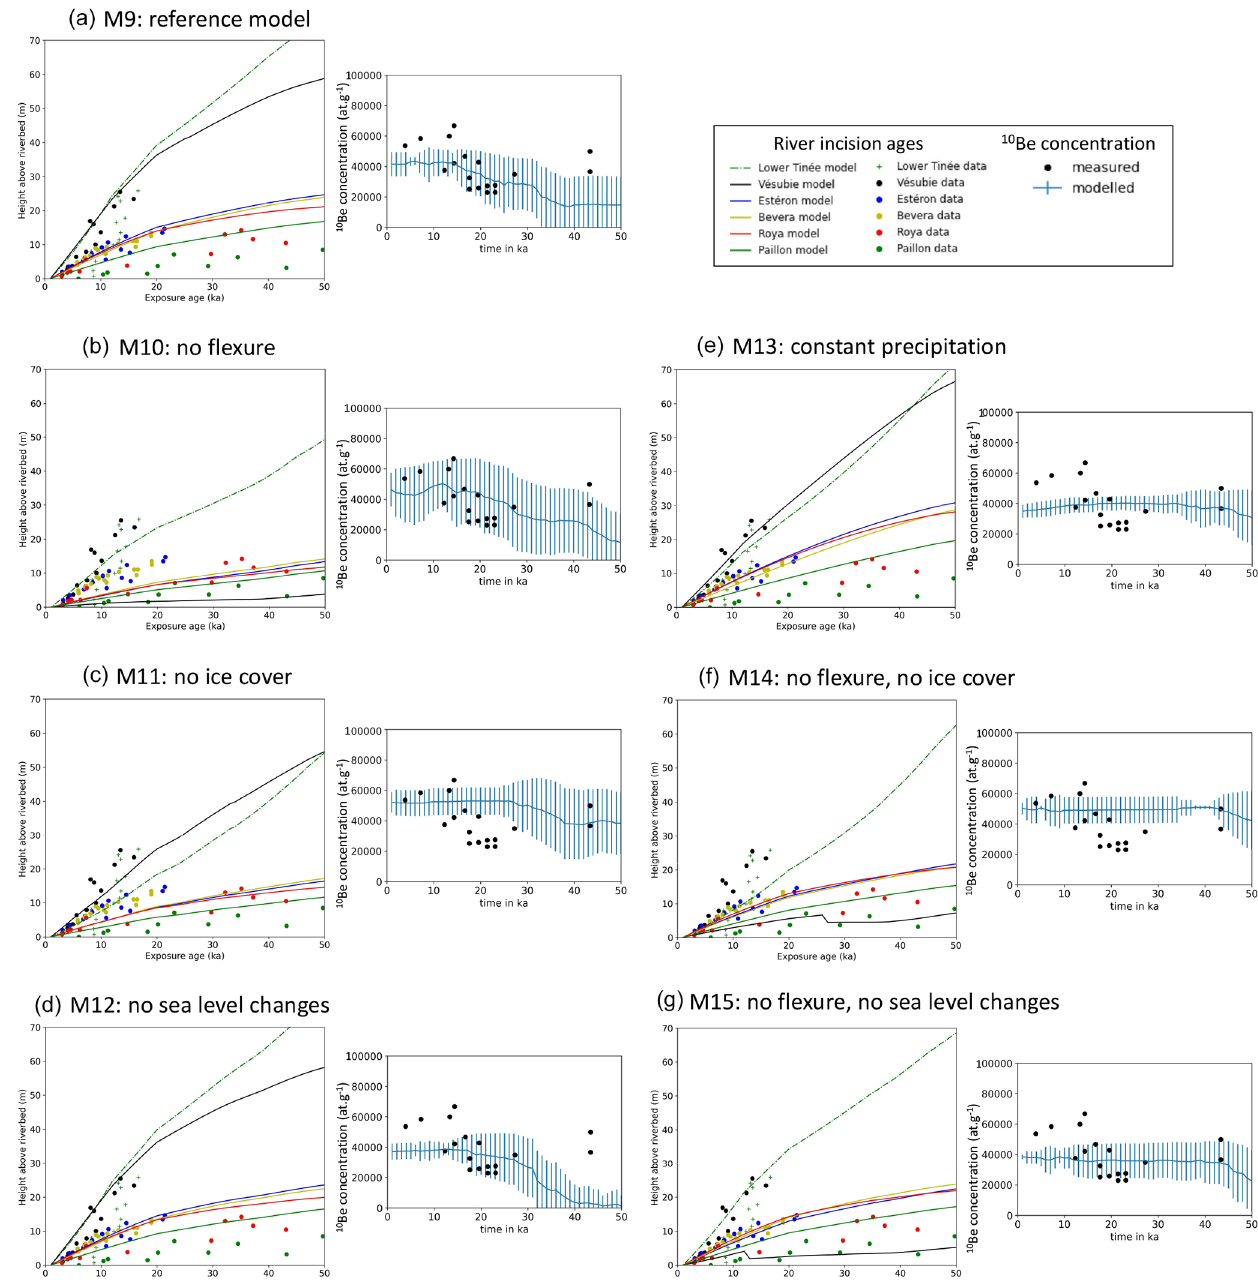
Figure 9. Comparison between model outputs and data from CRE ages in river-polished cliffs ( a – d ; see Fig. 2) and 10 Be MS ( e – g ; after Mariotti et al., 2021). Vertical bars in the right-hand graphs of each panel correspond to measured standard deviations in 10 Be MS in the sampled area (Fig. 8). See Table 3 for model